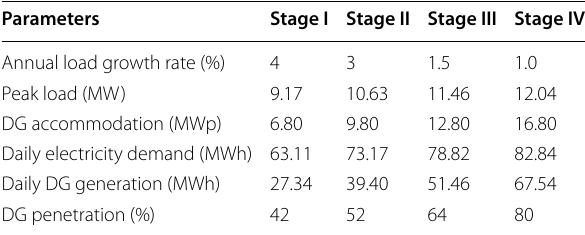
Table 2 Growth parameters of load and DG Parameters